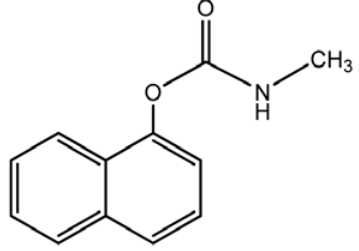
Fig. 1 . Carbaryl (insecticide